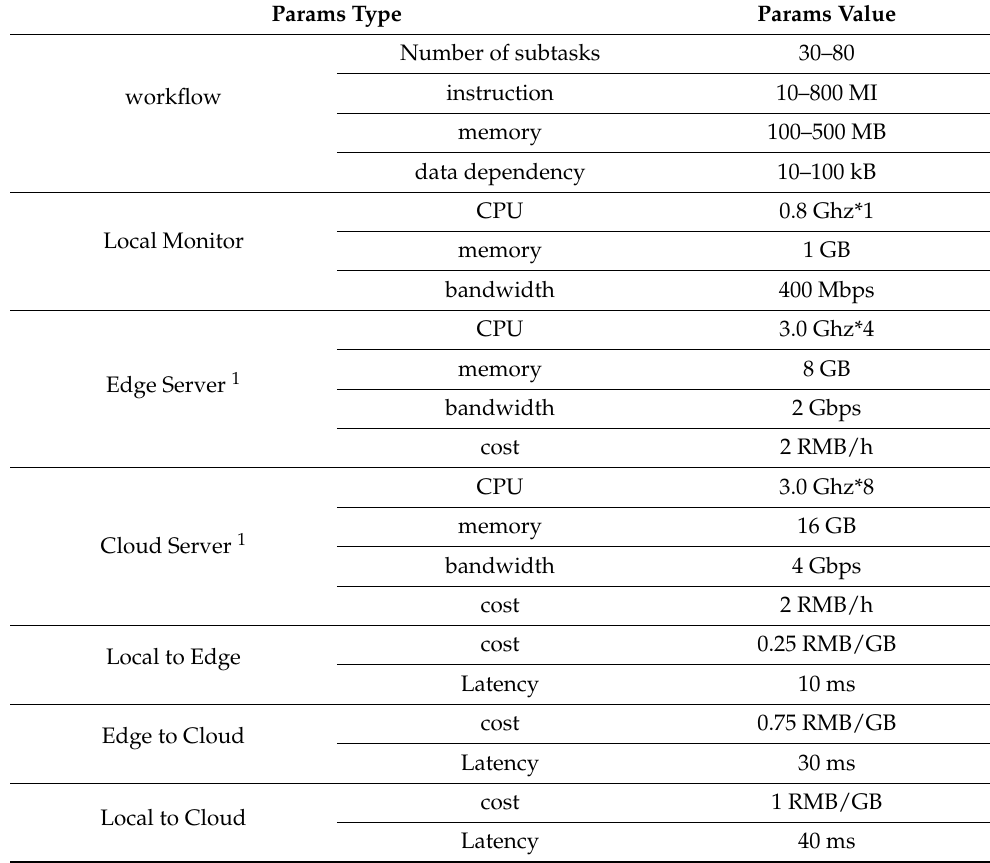
Table 3. Experimental